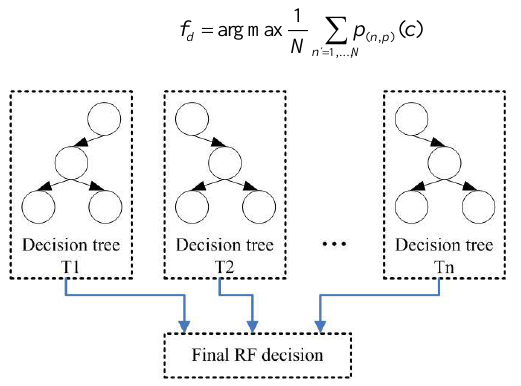
Figure 4. The illustration of the principle of random forest.